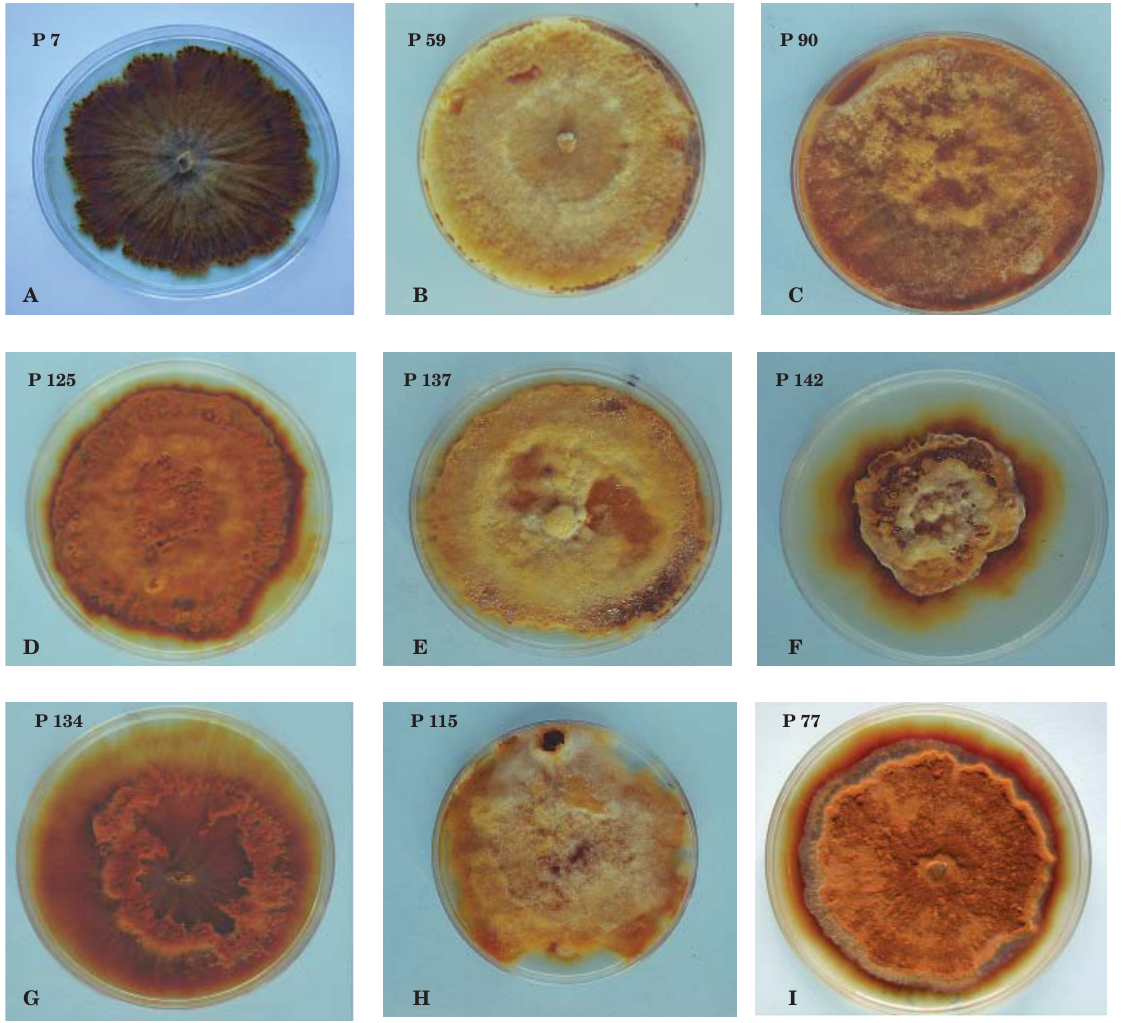
Fig. 3. Morphotypes A, B, C, D, E, F, G, H and I identified among colonies of Phellinus torulosus (P). The isolate code of each colony is shown in the upper left-hand corner of each